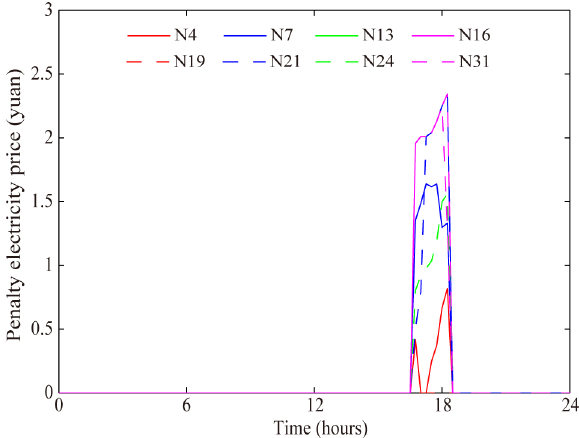
Figure 12. Penalty electricity price of each node.